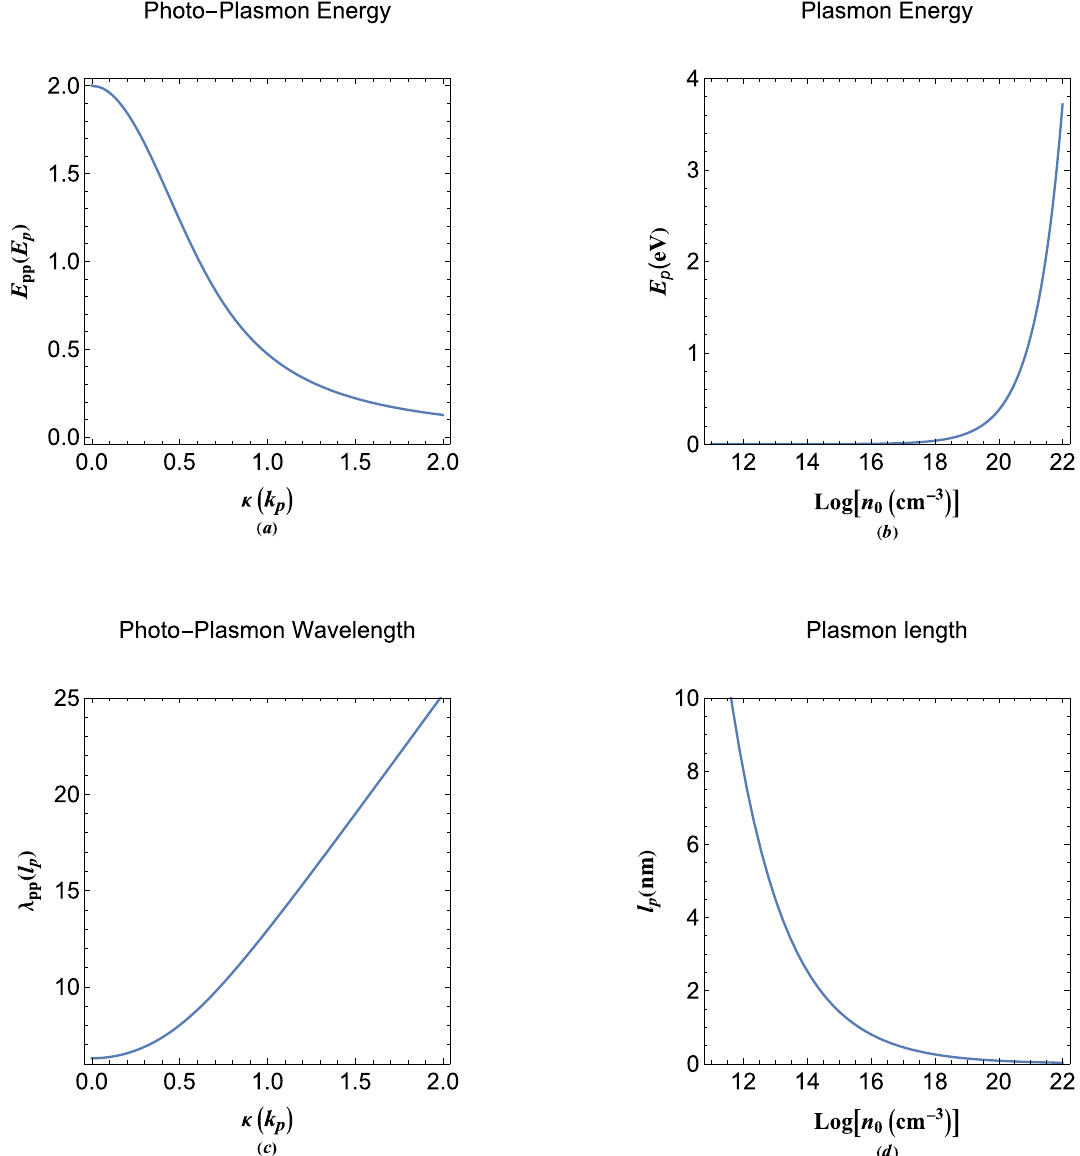
Figure 10. ( a ) Variation of photo-plasmon energy with the damping parameter which is related to the collective tunneling parameter in the plasmon units. ( b ) The variation in plasmon energy unit with electron number-density. ( c ) The variation of photo-plasmon wavelength with respect to the damping parameter. ( d ) The variation of plasmon length in nanometer unit with the electron